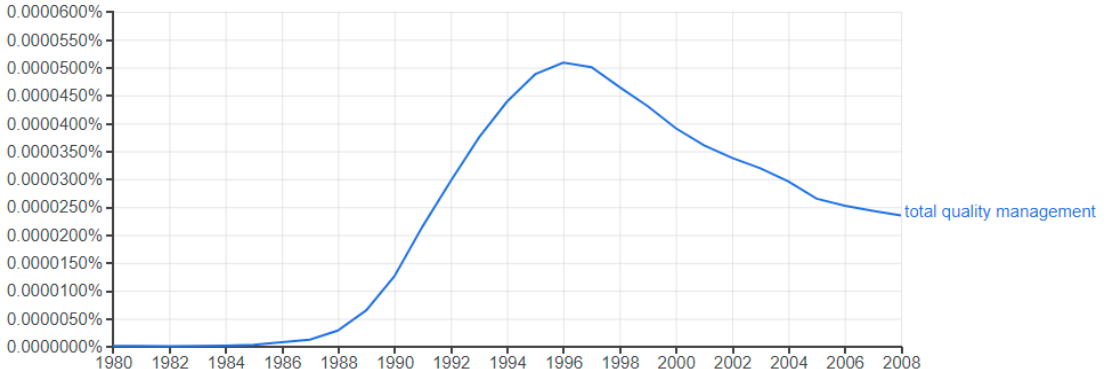
Figure 2. Data source: Google Books Ngram Viewer, available at http://books.google.com/ngrams, retrieved 07 December, 2017.